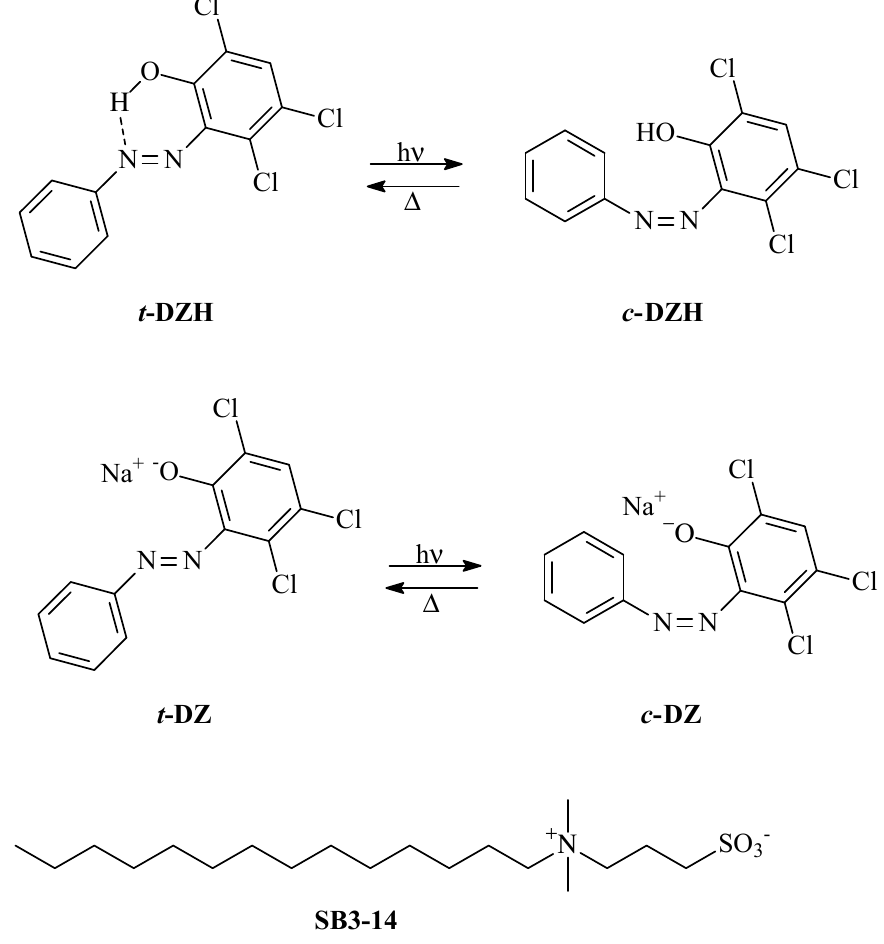
Figure 1. Photochromism of DZH , its conjugated base DZ, and structure of the SB3-14 surfactant. t -DZH is a well-known metastable photoacid [25]. In the E ( trans ) configuration, the acidity of the phenol group is reduced by the formation of a hydrogen bond with a nitrogen atom of the azo group (see Figure 1). The hydrogen bond is broken in the Z ( cis ) isomer. Therefore, the cis form is more acidic than the trans . t -DZH has been proposed as a compound to tailor pH pulses and oscillations upon an intermittent UV-irradiation [26,27]. It is also included among the most promising photochemically driven molecular motors